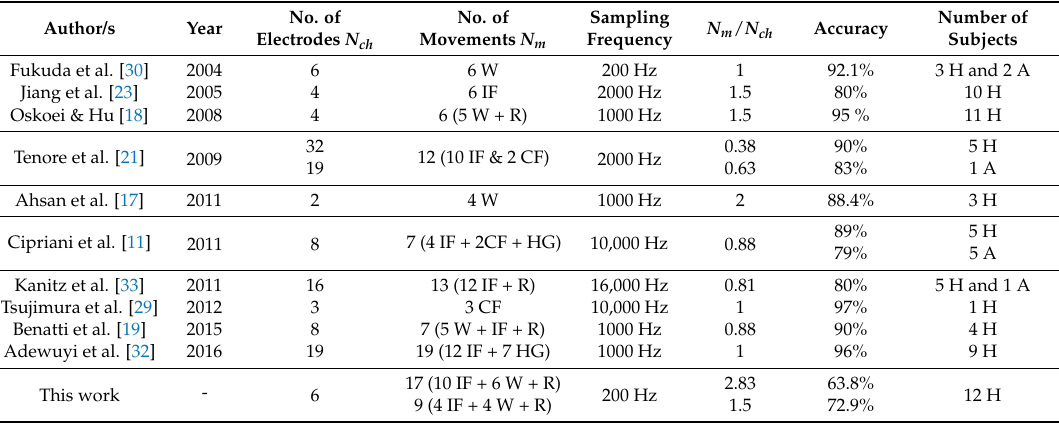
Table 3. Summary of existing EMG based pattern recognition studies.